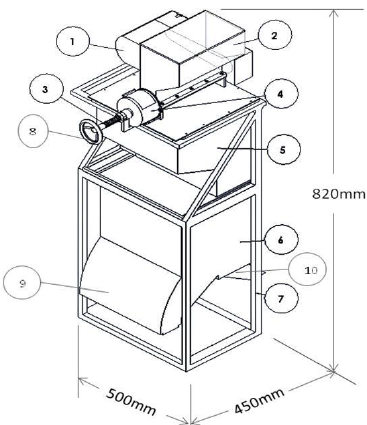
Figure 1. Isometric wireframe view of the machine: ① Electric motor; ② Hopper; ③ Regulating handleshaft; ④ Dehulling unit; ⑤ Drying unit; ⑥ Aspiration unit; ⑦ Frame; ⑧ Regulating handle for fixed disk; ⑨ Discharge for hull; ⑩ Discharge for seeds.